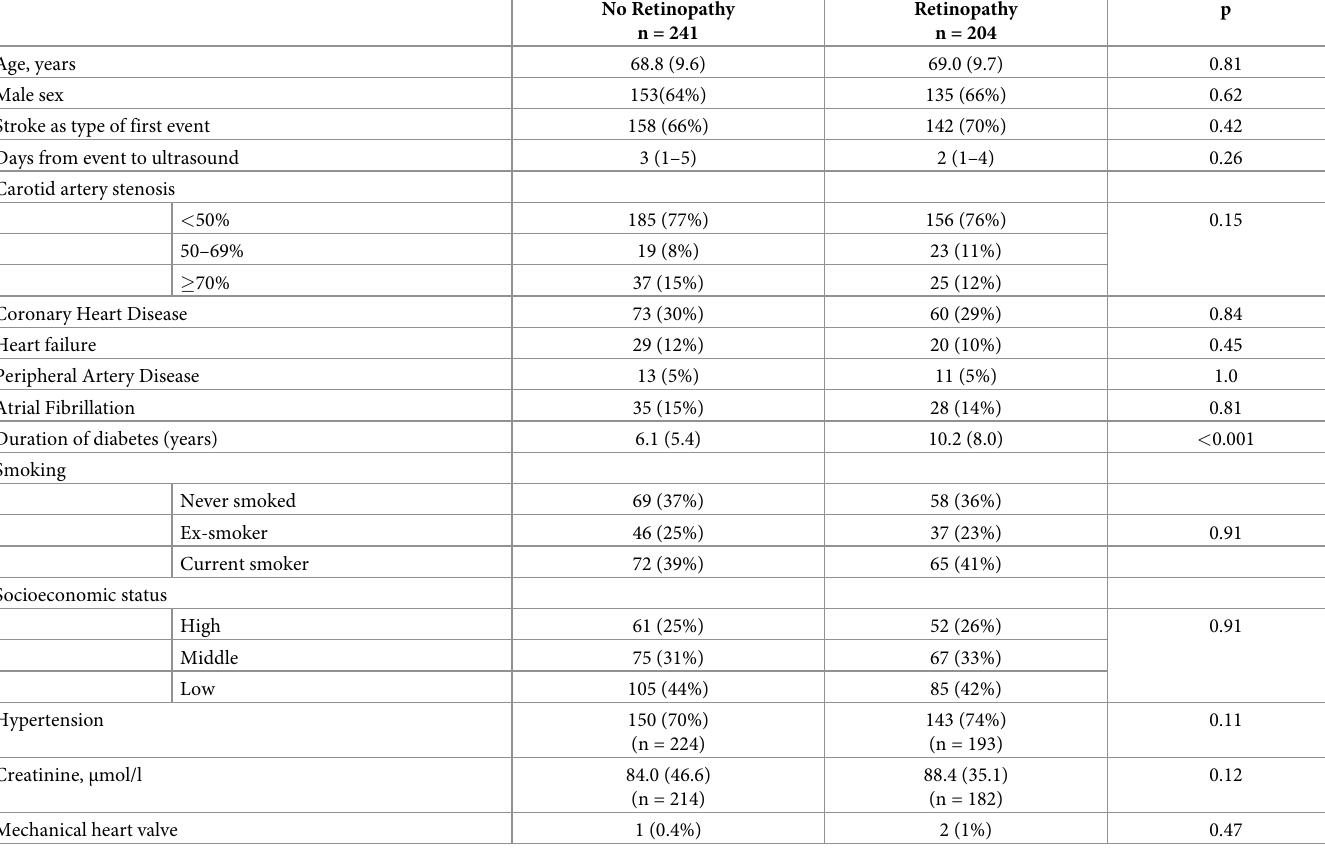
Table 2. Comparison of clinical characteristics between diabetes patients with and without